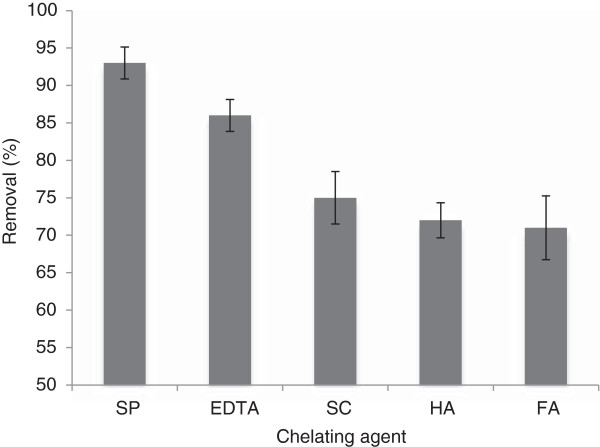
The pyrene removal efficiency for different CAs in pH 7, H
2
O
2
concentration of 300 mM, Fe
3+
concentration of 30 mM and Contact time of 6 h.